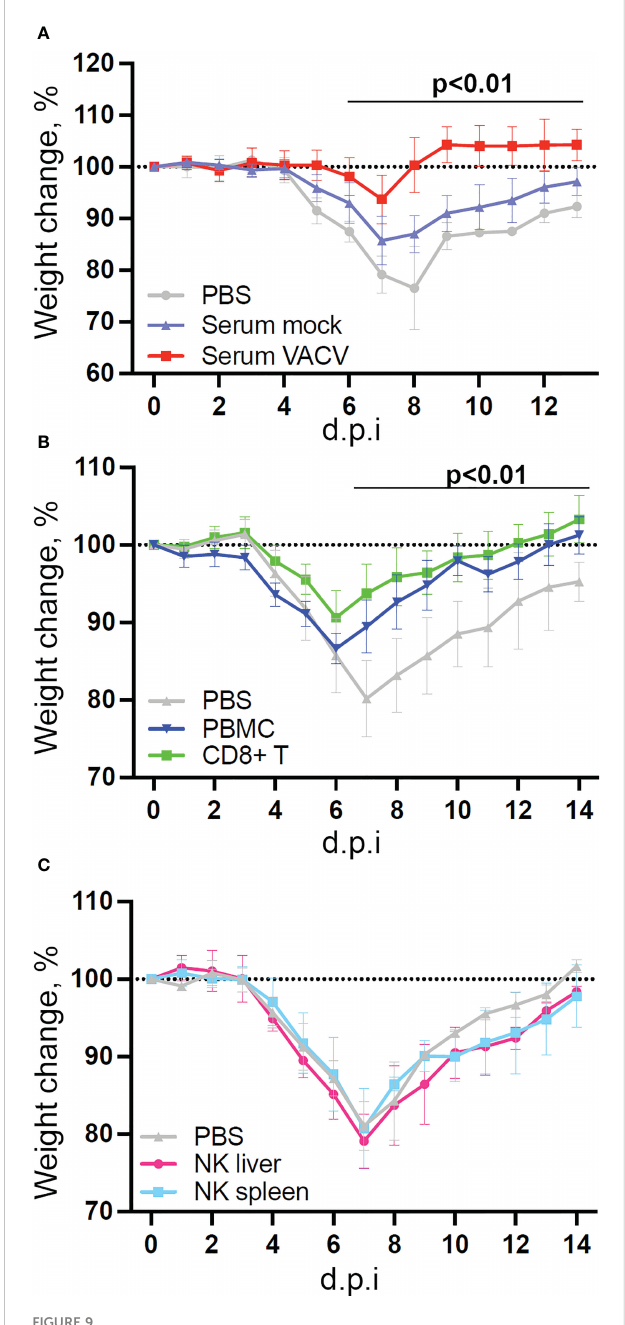
FIGURE 9 NK cells from vaccinated mice do not confer protection against challenge in a naïve host. C57BL/6 mice were infected i.d. with VACV WR or injected with PBS control and 28 days later (A) Serum was isolated from blood (n=5) or, (B) CD8 T cells (n=10) and PBMC (n=4) or (C) NK cells (n=5) or were puri fi ed from spleens. Serum, cells or PBS control (n=4-5) was injected into the tail vein of naïve mice and 24 h later (Day 0) mice were infected i.n. with 10 5 p.f.u. of VACV WR. Weight change was monitored over the following 14